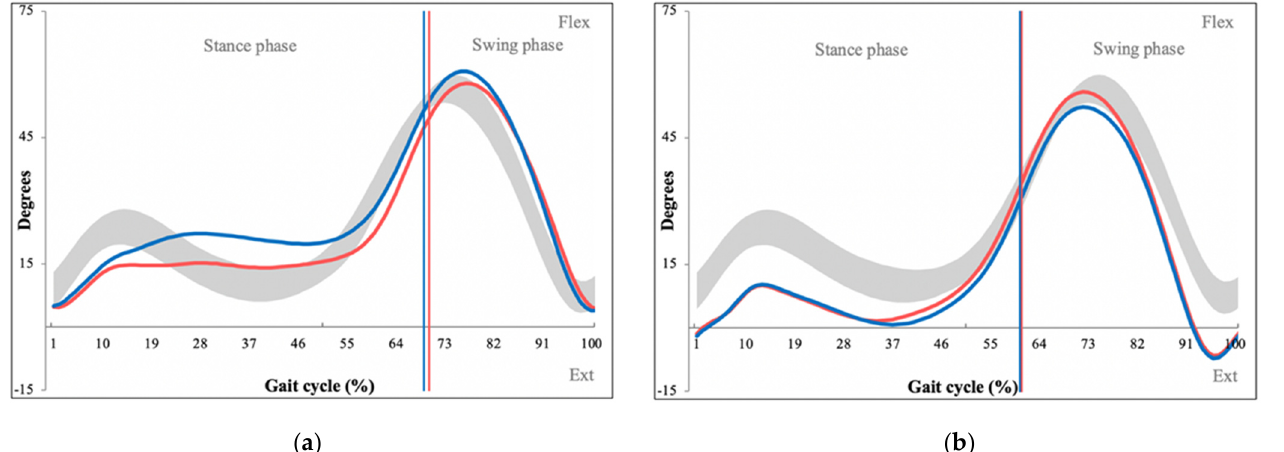
Figure 9. Kinematic graphs of knee flexion and extension of a patient with LSS ( a ) and their matched control ( b ), demonstrating comparable degrees of motion within the knee. Degrees of movement are shown on the vertical axis whereas the horizontal axis portrays gait cycle. (Red line—left leg values, blue line—right leg values, grey space—normative values of knee flexion/extension.) No statistically significant correlations were found between kinematic parameters with ODI scores or age.